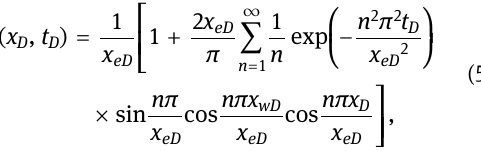
fi nite - w in an in